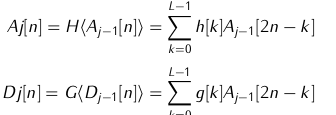
signal only, without rectification. To leave out the test case subjectivity, the Normalization Unit applies maximum voluntary contraction normal- ization algorithm and generates normalized IEMG (nIEMG) signals [20].